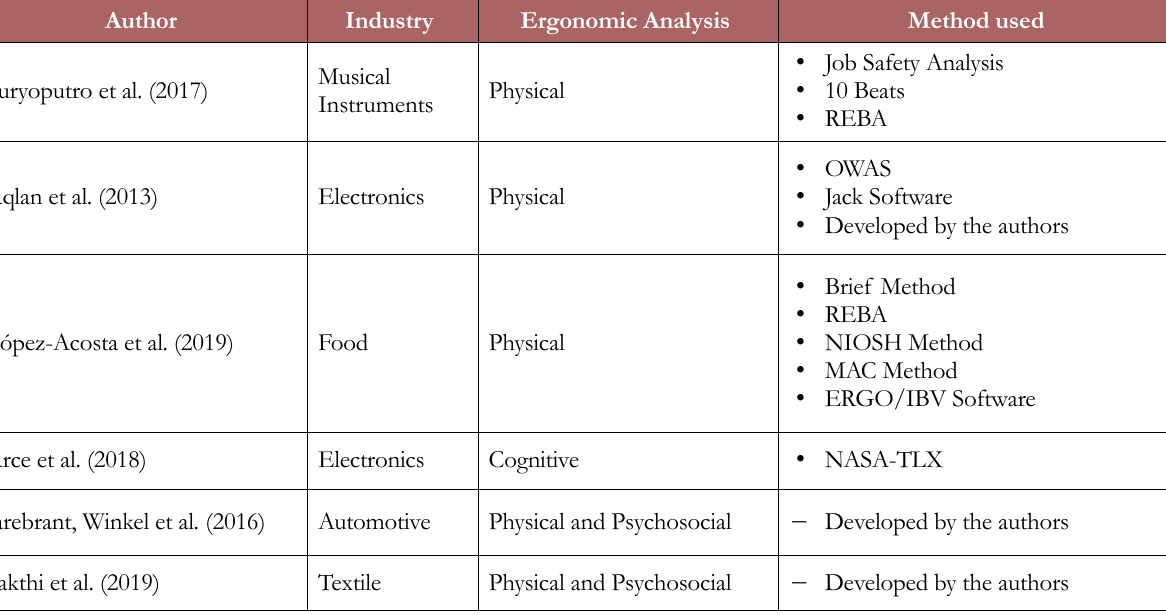
Table 4. Articles that include ergonomic analyses and the methods